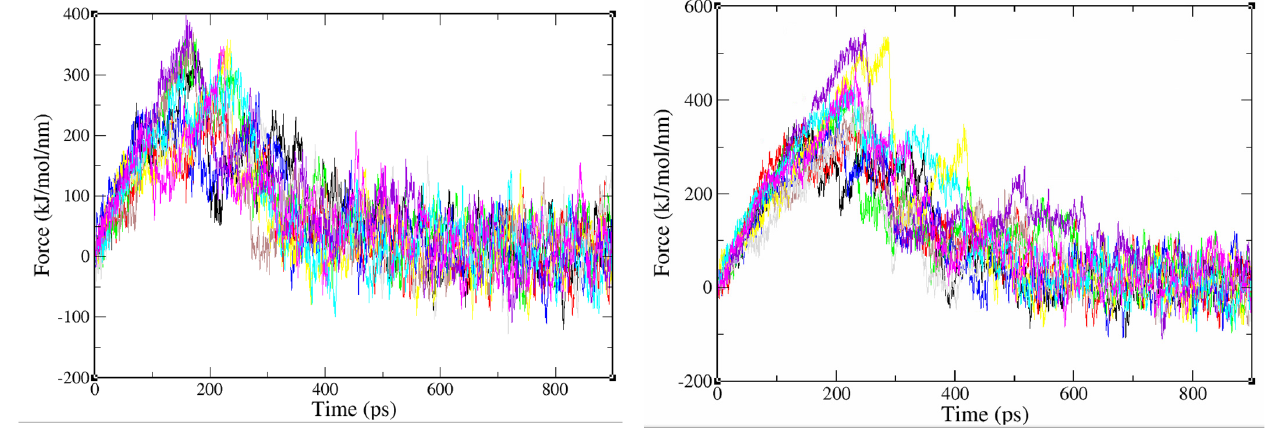
7 of 14 Table 2. SMD Results from 20 independent trajectories.